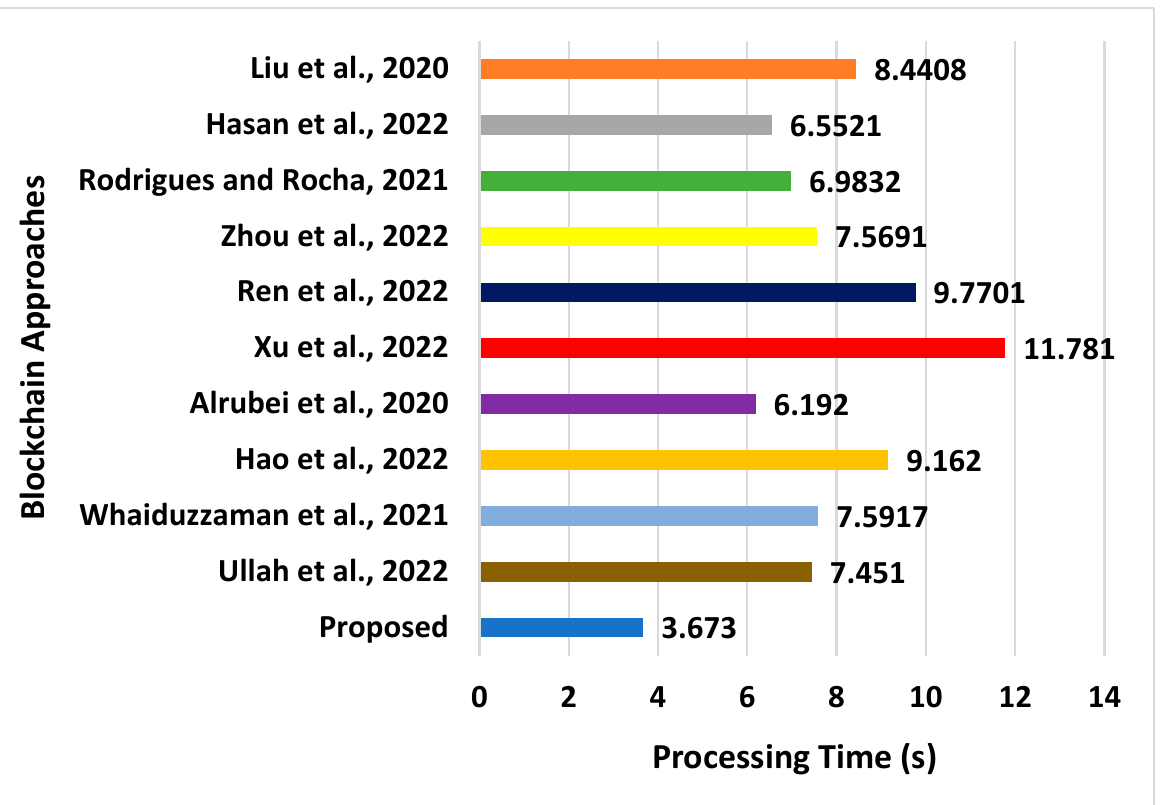
Figure 6. Analysis of processing time [39–48].